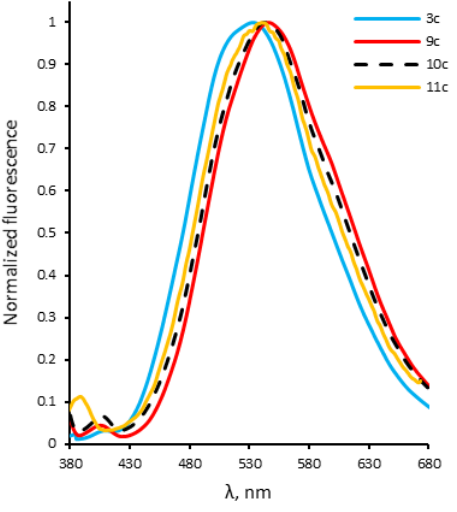
Figure 6. Normalized fluorescence spectra in acetonitrile for derivatives bearing para -methoxyphenyl groups.